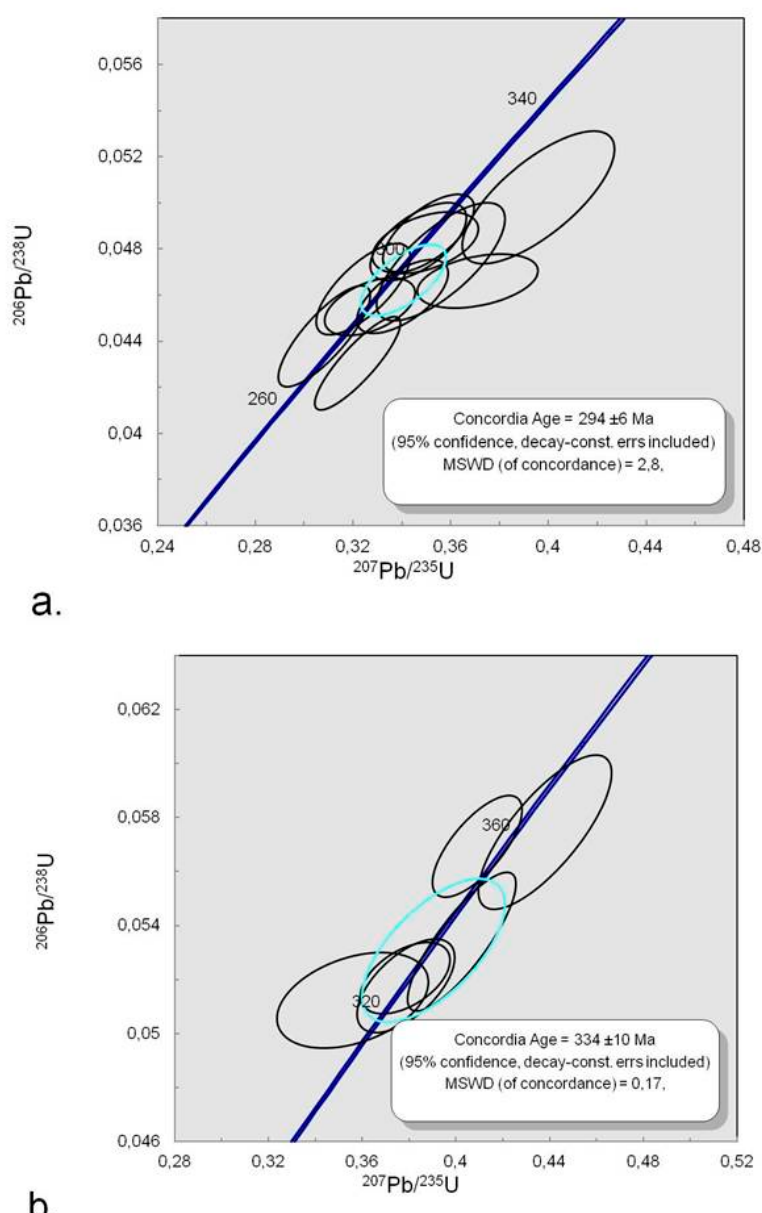
Figure 15. Concordia diagram for zircons from kyshtymite sample 8-K: ( a ) Concordia ages at 294 ± 6 Ma; and ( b ) 334 ± 10 Ma.